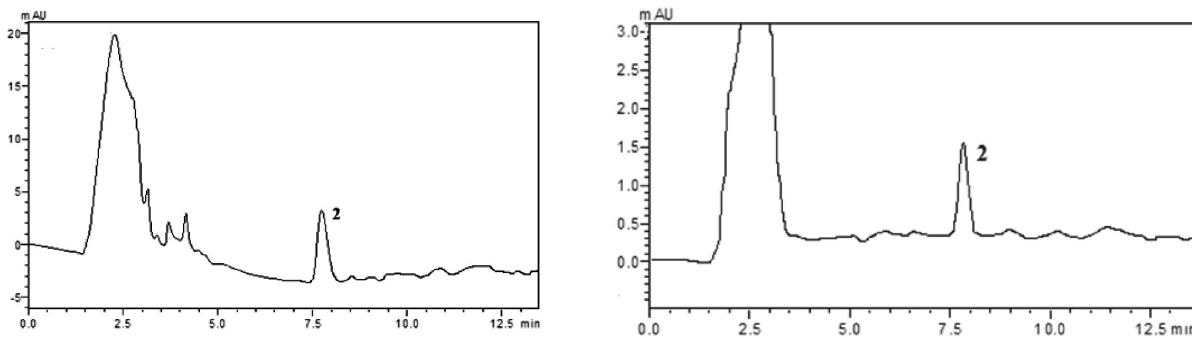
Figure 2. RP - HPLC c hromatogram of biogenic amines obtained for the apple juice samples; (a): Sample 1, (b): Sample 2; (2) tyramine. Chromato- graphic conditions were the same as in given Fig. 1. (see Table 3 for analytical